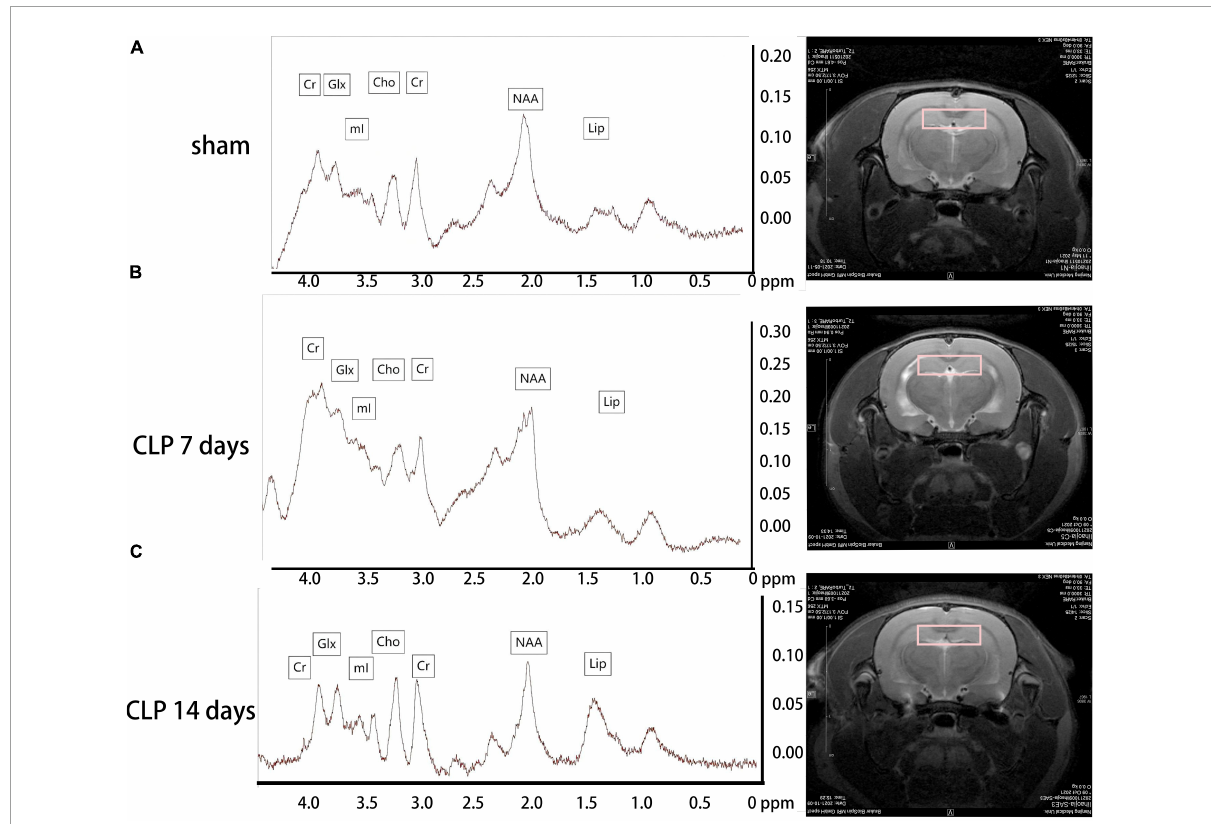
FIGURE2 Metabolites in the hippocampus detected by 1H-MRS. Metabolites in the hippocampus were analyzed by 1H-MRS, and the spectrums determined by MestReNova. The representative metabolite spectrum in the hippocampus of rats and region position in the coronal image in the sham group (A) ; in the day 7 post CLP group (B) ; in the day 14 post CLP group (C)